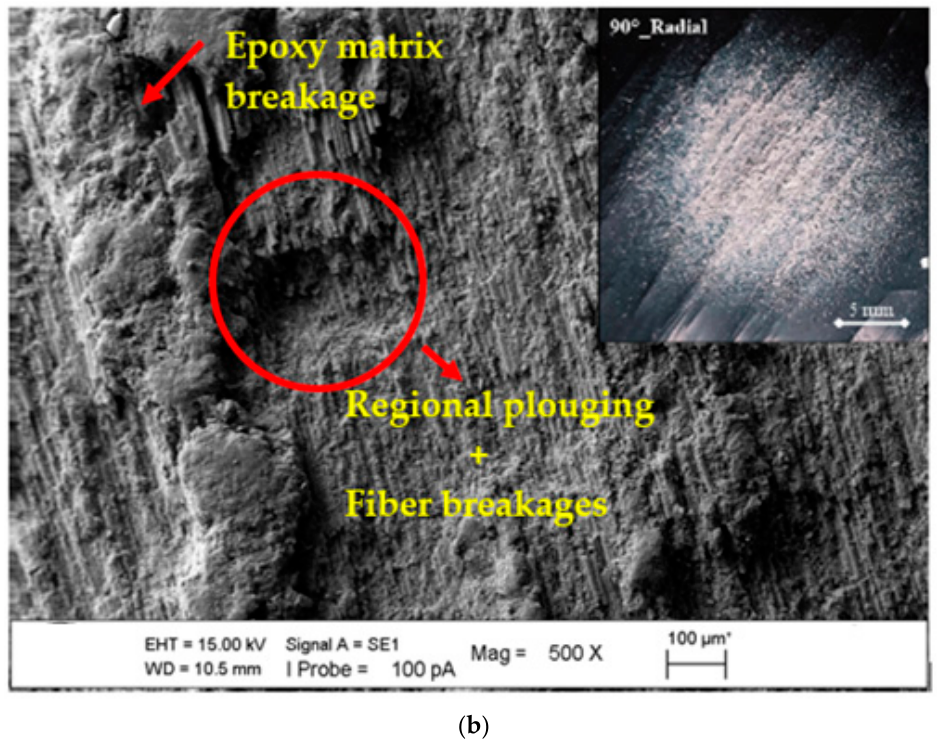
Figure 14. SEM images of matrix damages and fiber breakage on the surface at the radial orientation in the lamina region with the changing impingement angle: ( a ) 60° and ( b ) 90°.